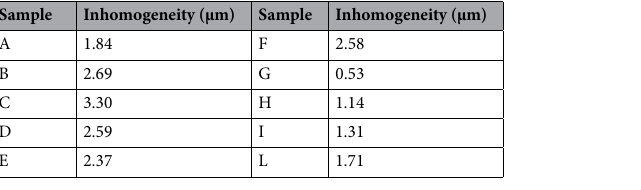
Table 2. Standard deviation, considered as an estimator of deposit uniformity, relative to each sample.